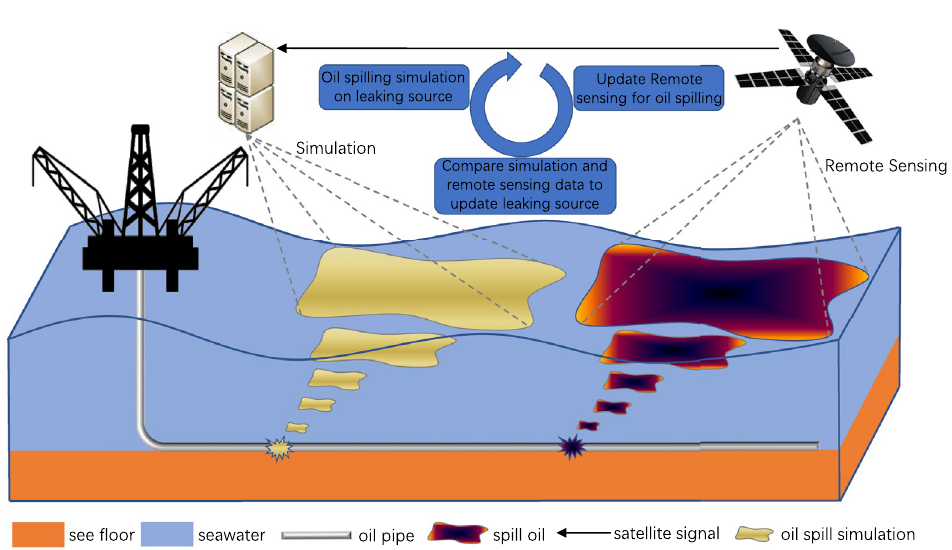
Figure 1. Illustration on remote sensing helped offshore oil spill monitoring and detection in offshore petroleum CPS based emerging